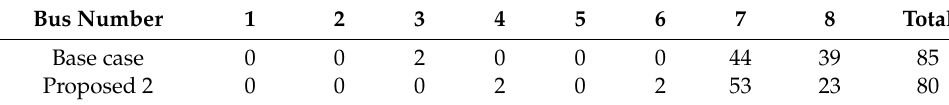
Table 5. Optimal placement and optimal capacity of storage batteries.